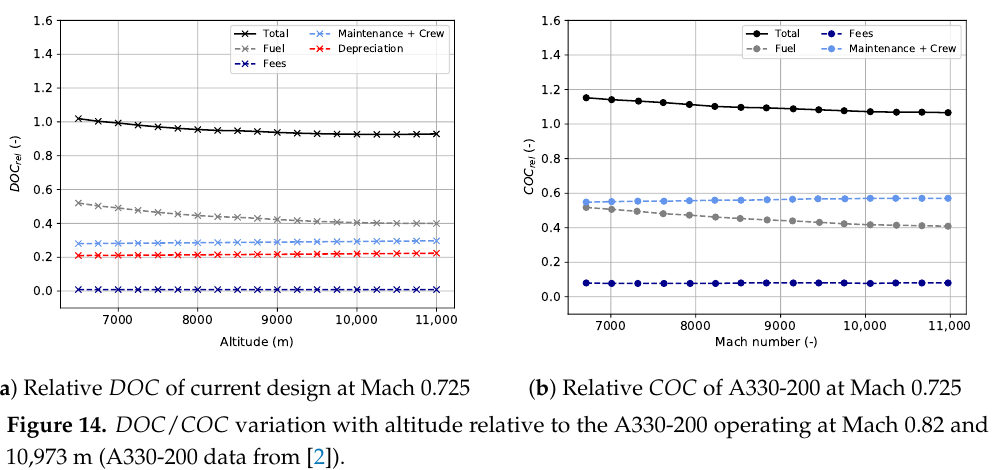
Figure 14. DOC / COC variation with altitude relative to the A330-200 operating at Mach 0.82 and 10,973 m (A330-200 data from [2]).